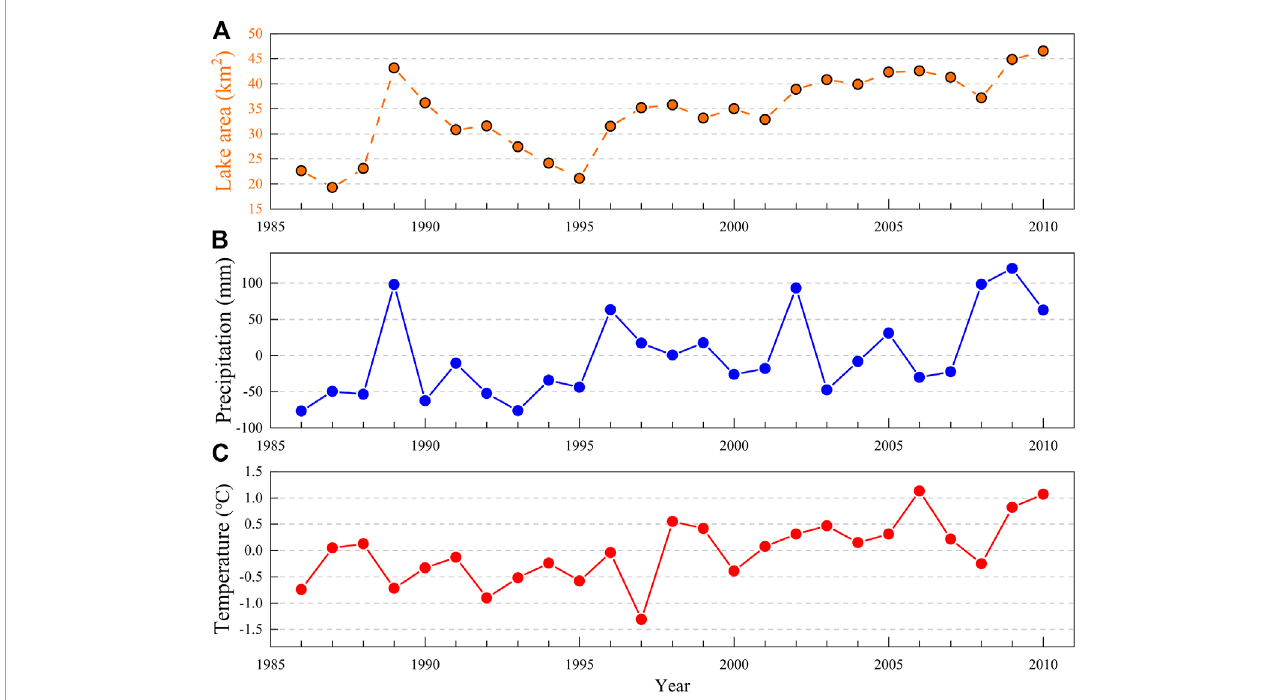
FIGURE 9 Changes in lake area and climate fluctuations from 1986 to 2010: (A) lake area, (B) precipitation and (C) temperature.